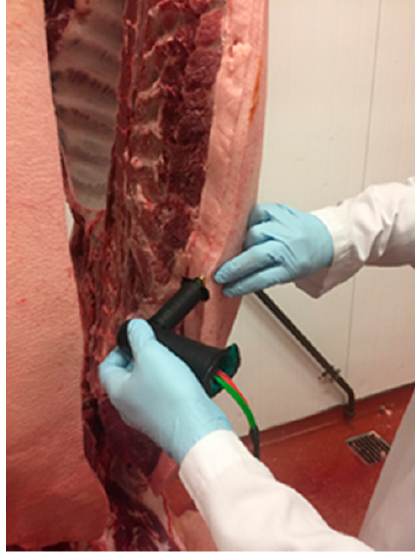
Figure 4. Evaluation of a carcass with University of West England (UWE) Electrochemical biosensor system (photo courtesy of O. Doran, A. Crew and J.